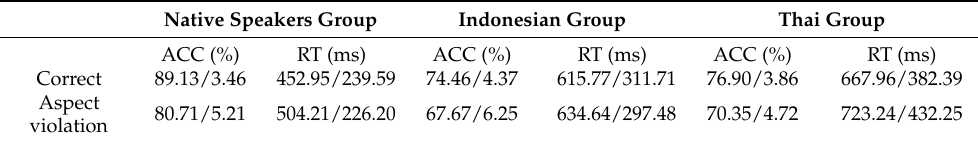
Table 4. Average accuracy (ACC) rate and reaction time (RT) of different sentences in each group. Native Speakers